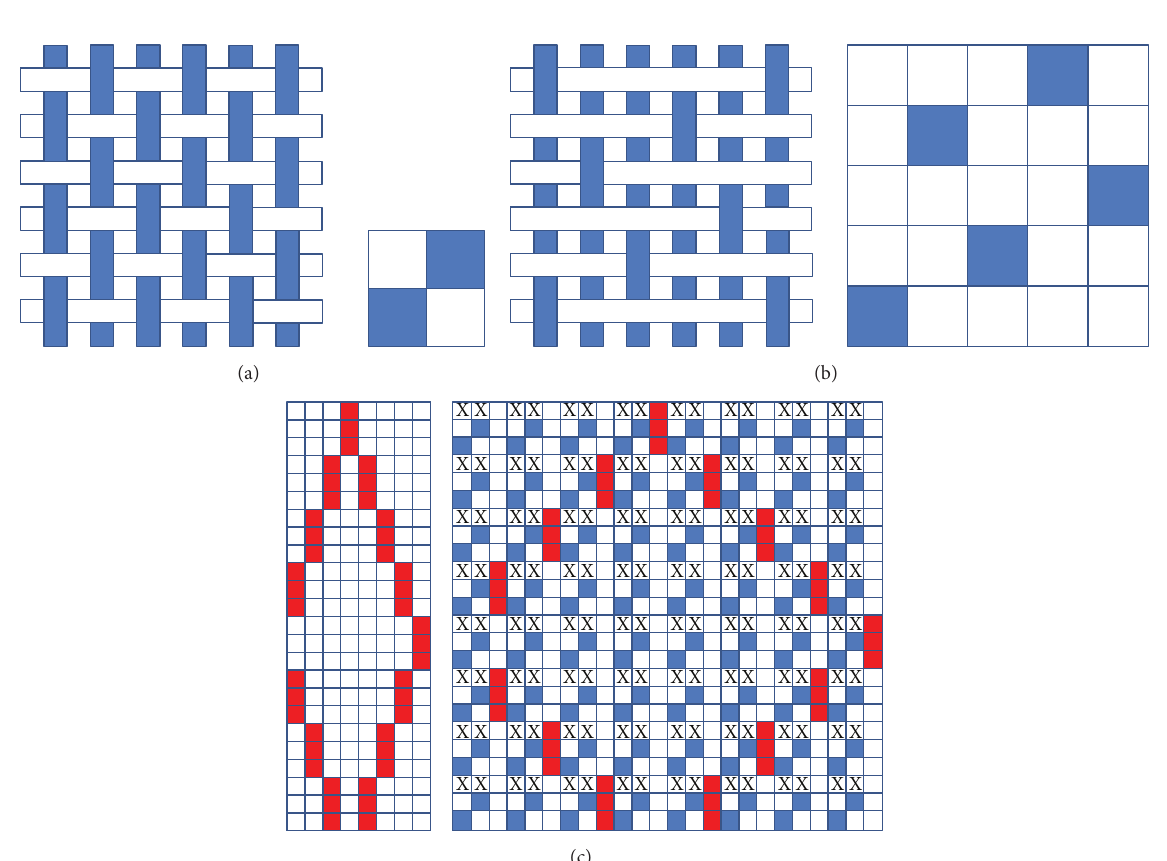
Figure 1: Weave repeats in flat view and equivalent weave patterns of plain (a), satin (b), and piqu´e ((c), simplified sketch) fabrics.